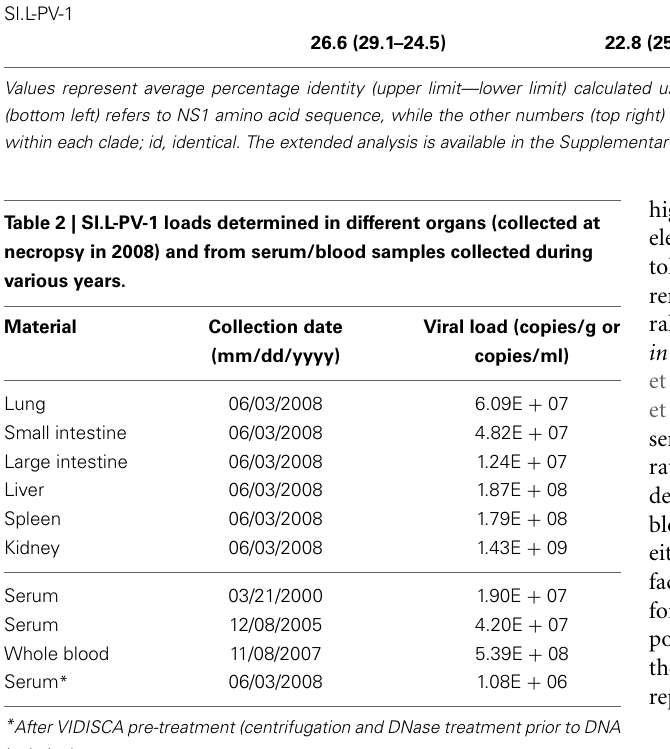
Values represent average percentage identity (upper limit—lower limit) calculated using representative members of each species in the clades. Values in bold (bottom left) refers to NS1 amino acid sequence, while the other numbers (top right) refer to VP1 amino acid sequence. On the diagonal in italic are the identities within each clade; id, identical. The extended analysis is available in the Supplementary Tables 1, 2.